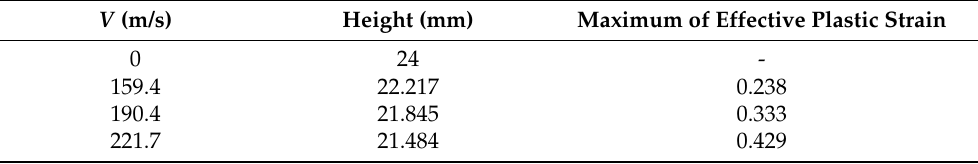
Figure 11. Effective plastic strain contour plot at different velocities: ( a ) v = 159.4 m/s; ( b ) v = 190.4 m/s and ( c ) v = 221.7 m/s. Table 3. The main results from Taylor impact finite element model.